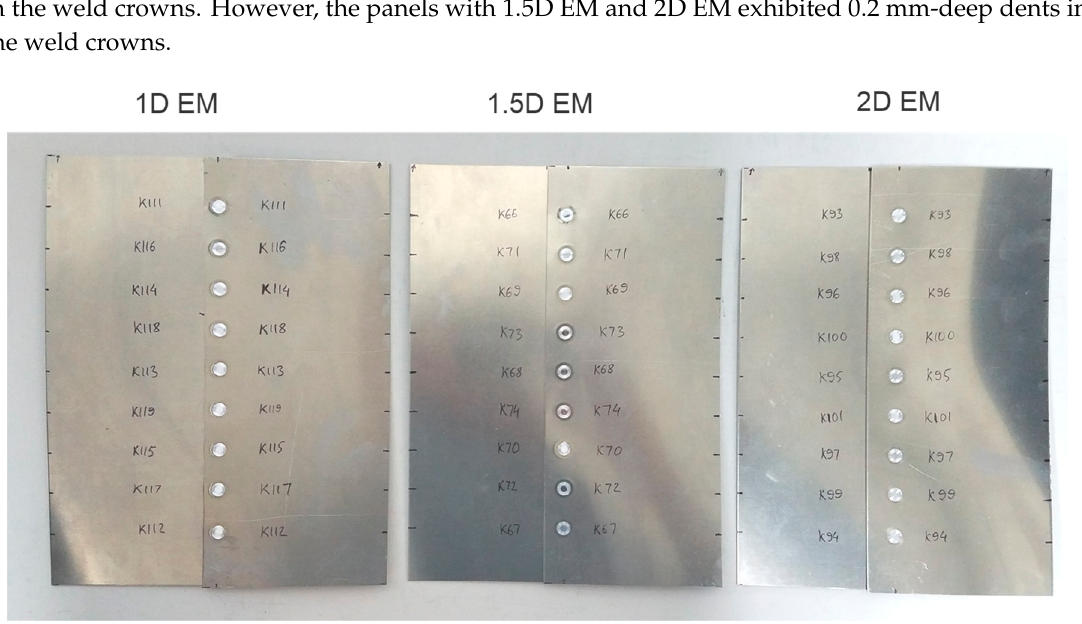
Figure 8. Nine-spot-welded panels with 3D-pitch. EM is the edge margin. D ( = 7 mm) is the spot weld diameter.